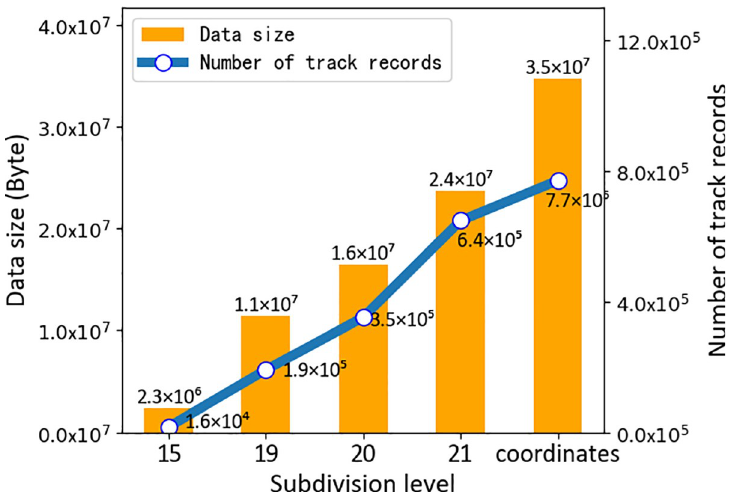
Fig 5. Data size and number of track records at different subdivision levels. Data size refers to the storage size of the airspace, 5G and UAV information under the same airspace using different levels of GeoSOT-3D grids and coordinates methods. The number of track records indicates the number of UAV tracks stored in the airspace.